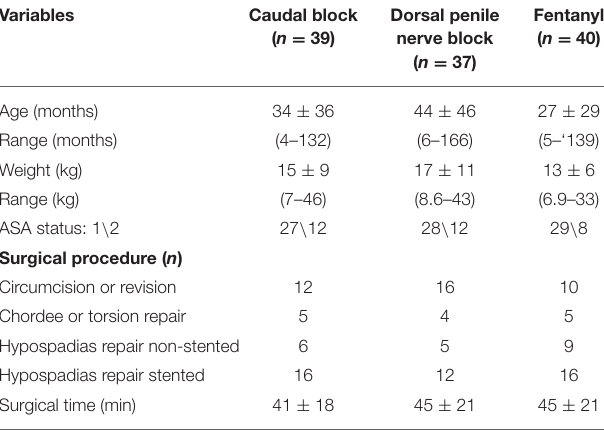
TABLE 1 | Demographic and surgical